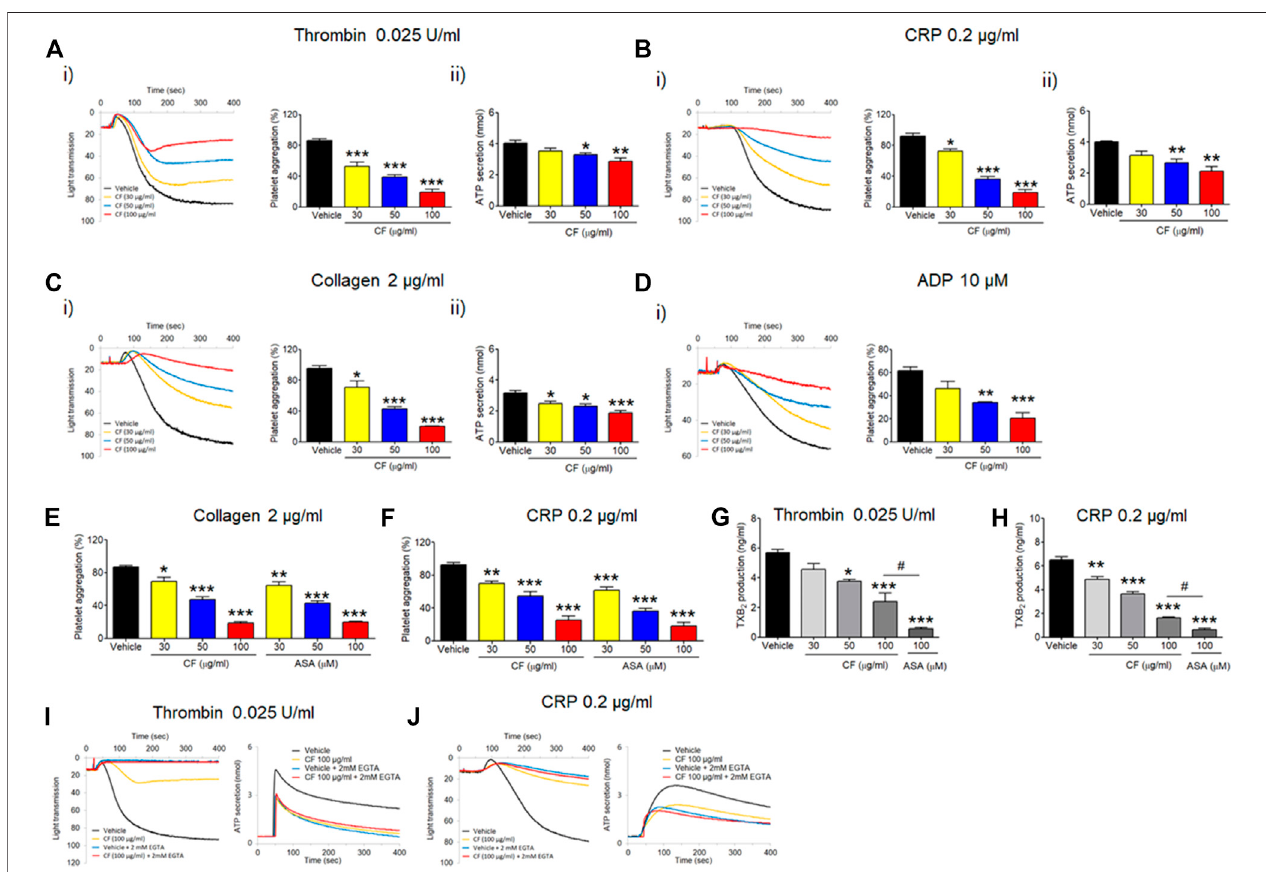
FIGURE 1 | Inhibitory effect of C. fragile on platelet aggregation, ATP secretion, and TxB2 production following stimulation with various agonists. Washed mouse platelets were preincubated with various concentrations of C. fragile (30, 50, and 100 μ g/ml) for 10 min at 37 ° C and then stimulated with 0.025 U/ml Thrombin (A) , 0.2 μ g/ml CRP (B) , 2 μ g/ml Collagen (C) , and 10 µM ADP (D) . In the ADP-induced aggregation assay, 30 μ g/ml of human FG was added to the platelet suspension before ADP stimulation. In some experiments, washed platelets were pretreated with C. fragile (30, 50, and 100 μ g/ml) or ASA (30, 50, and 100 µM) and then stimulated with 2 μ g/ml Collagen (E) and 0.2 μ g/ml CRP (F) . Aggregation was measured for 5 min at 37 ° C under constant stirring (1,000 rpm) conditions in a platelet aggregometer (Chrono-Log). (i) Platelet aggregation and quantitative graphs. The effect of C. Fragile on T X B2 generation was measured using a TXB2 ELISA assay kit (G,H) . In the ADP secretion, washed platelets were preincubated with various concentrations of C. fragile (30, 50, and 100 μ g/ml) for 10 min at 37 ° C before adding a luciferin/luciferase reagent. After the luciferin/luciferase reagent added, platelets were stimulated with 0.025 U/ml Thrombin (A) , 0.2 μ g/ml CRP (B) , and 2 μ g/ml Collagen (C) . (ii) ATP secretion was measured using a luminometer. In other experiments, mouse platelets were preincubated with a high concentration of C. fragile (100 μ g/ml) and activated with 0.025 U/ml Thrombin (I) and 0.2 μ g/ml CRP (J) in the presence of 20 mM EGTA. Aggregation and ATP secretion were monitored with a platelet aggregometer. All data represent the mean ± SD ( n (cid:2) 5). *: p < 0.05, **: p < 0.01, and ***: p < 0.001 vs. vehicle control after ANOVA and Dunnett ’ s